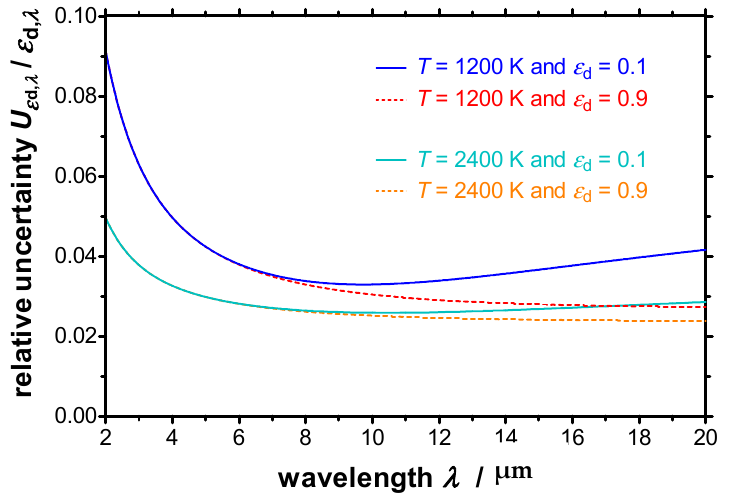
Figure 10. Relative expanded standard uncertainty of the spectral directional emissivity at two dif- ferent temperatures for a low emissivity of 0.1 and a high emissivity of 0.9.